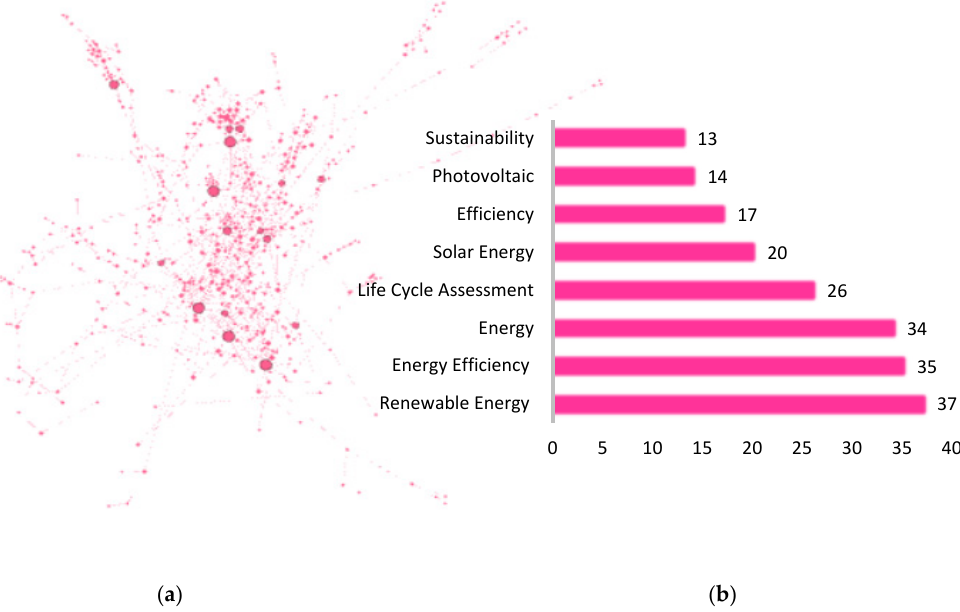
Figure 19. Sustainability of power systems: ( a ) manuscripts published, ( b ) keywords.